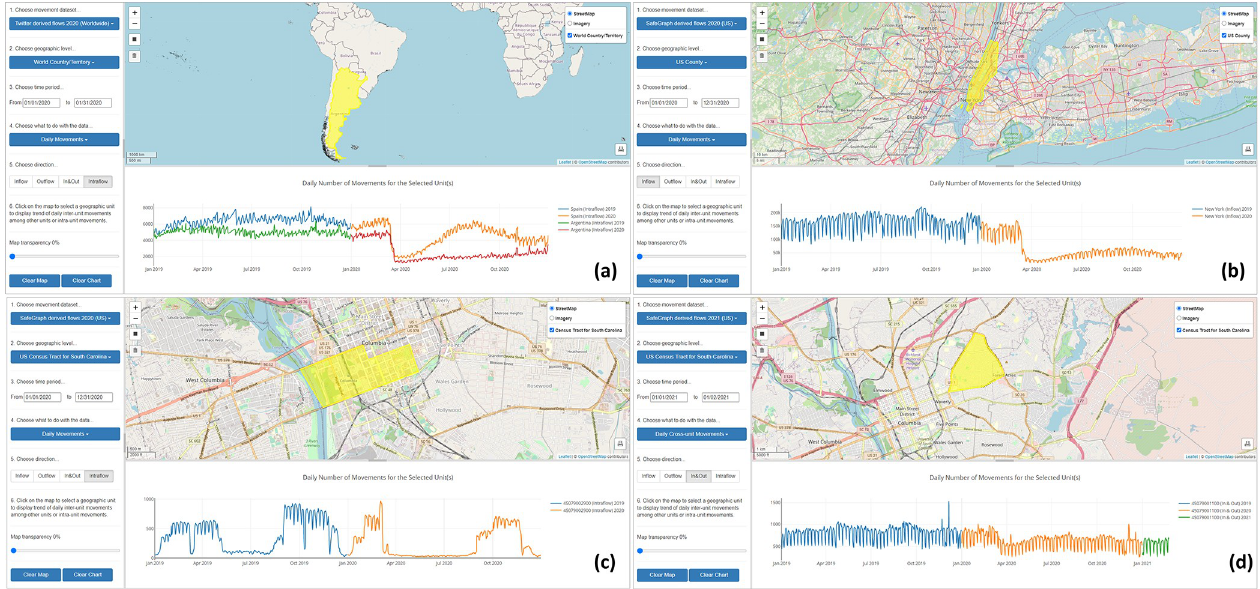
Fig 7. Daily population movement in different geographic scales. (a). Intraflow for Spain (top line) and Argentina (bottom line) in 2019 and 2020; (b) Inflow for New York County, U.S. in 2019 and 2020; (c) Intraflow for a census tract in Columbia, South Carolina (mainly located within the University of South Carolina) from 01/01/2019 to 02/24/2021; (d) Interflow (In&Out) for a census tract in a residential area of Columbia from 01/01/2019 to